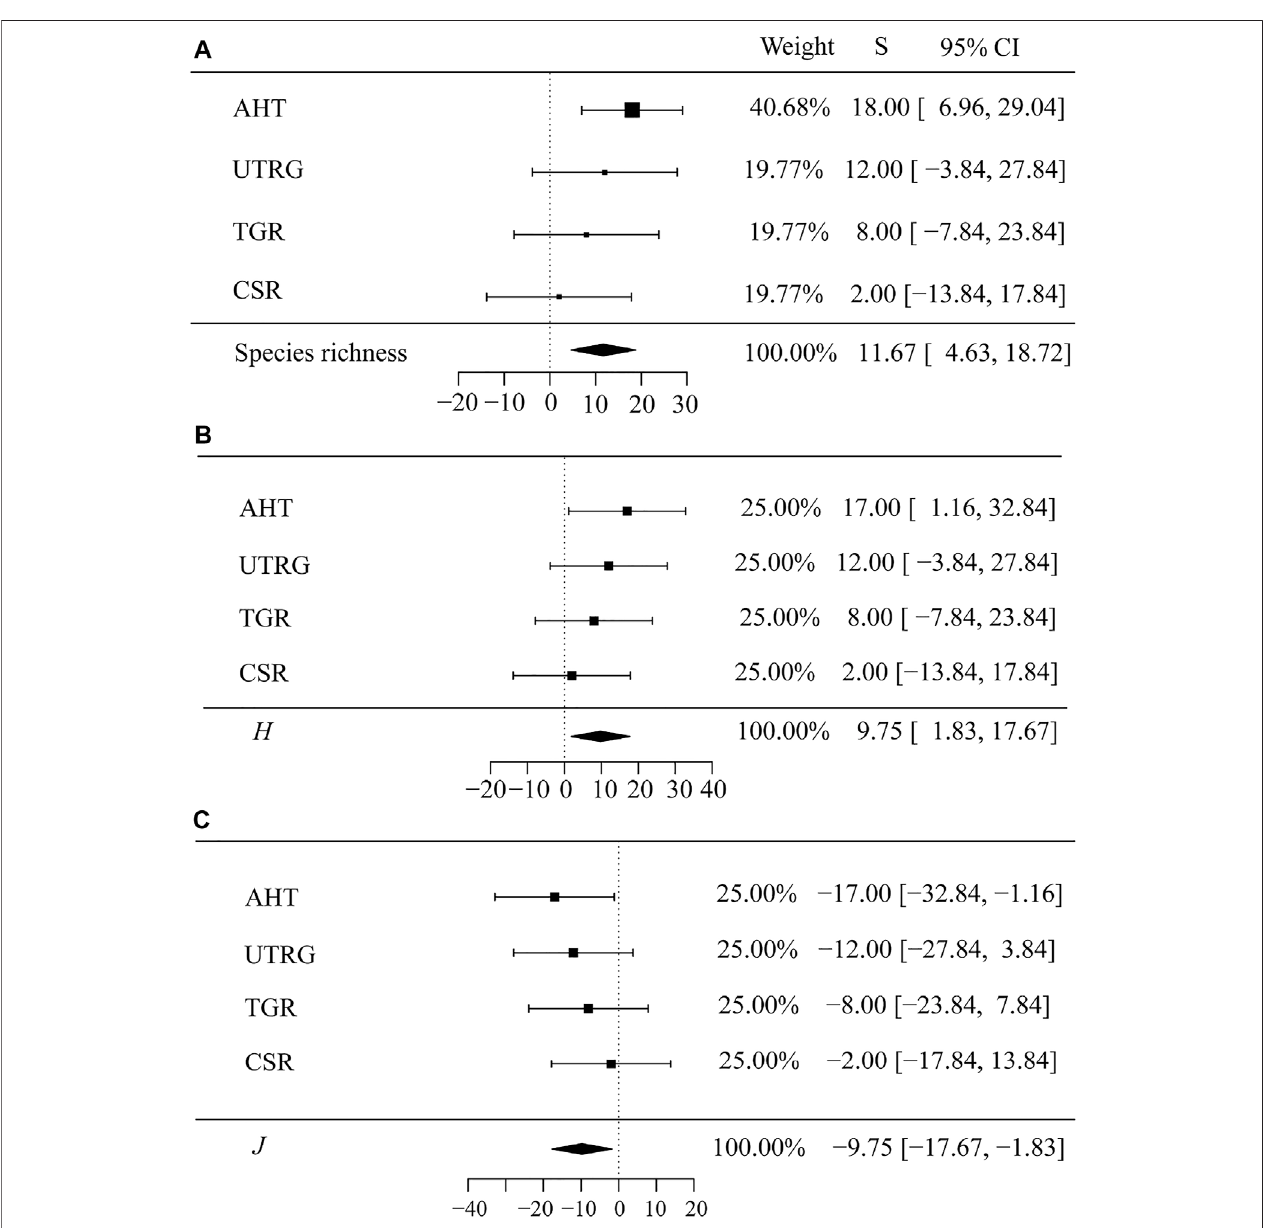
FIGURE 4 | Temporal changes in the species diversity of fi sh communities in the different habitat types in the upper reaches of the Yangtze River. (A) Species richness; (B) Shannon-Wiener diversity; (C) Pielou ’ s evenness.